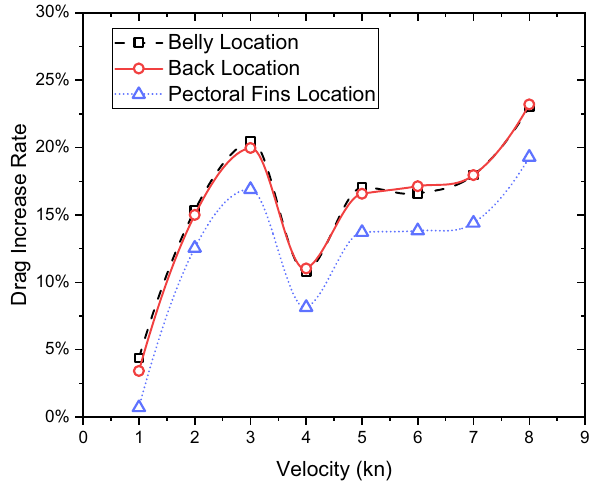
Figure 26. The increase rate of the total drag on the shark plus remora in different